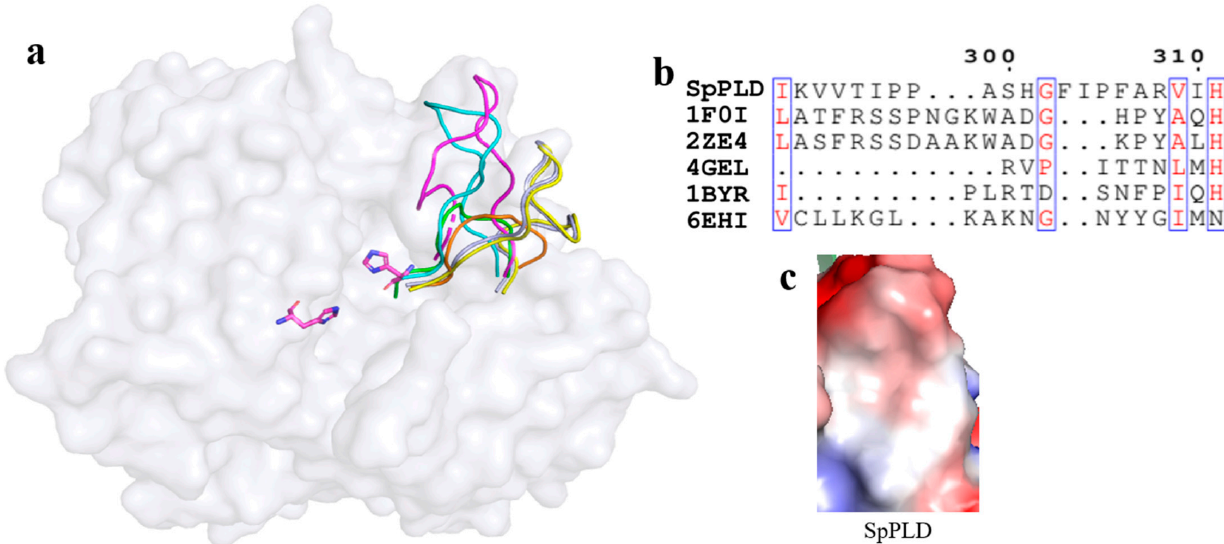
Figure 9. ( a ) Superimpostion and comparision the loop between β 11 and β 12 with other PLDs. SpPLD (magentas, PDB ID: 7E0M), Streptomyces sp . PMF PLD (yellow, PDB ID: 1F0I), SaPLD (light blue, PDB ID: 2ZE4), Zuc (orange, PDB ID: 4GEL), NucT(cyans, PDB ID: 6EHI), Nuc (green, PDB ID: 1BYR). Two catalytic sites of SpPLD were shown in stick. ( b ) Sequence alignment of the amino acids that composed the loop between β 11 and β 12 in SpPLD with other PLDs. ( c ) Electrostatic surface potential profile of the loop between β 11 and β 12 of